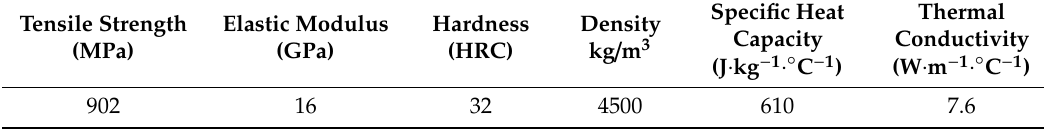
Figure 4. ( a ) Schematic view of the UEVC process in the machining of the micro-groove; ( b ) Enlarged view of the machined micro-groove. Table 1. Physical properties of Ti-6Al-4V alloy.